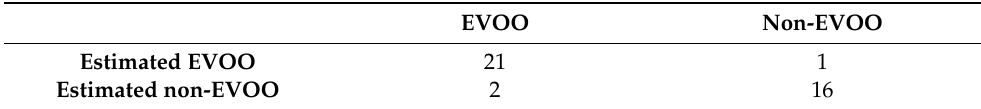
Table 3. Results of the KNN test in the case of two quality grade classes (EVOO and non-EVOO) and the HAS reagent.